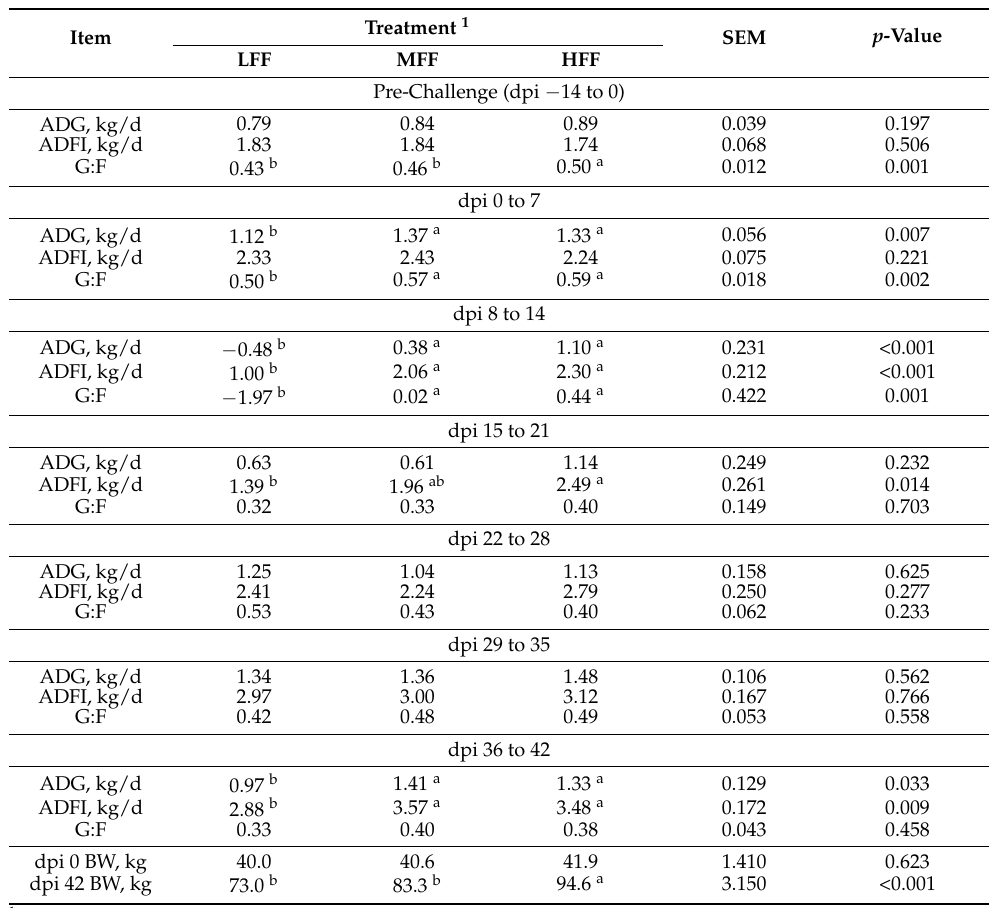
Table 3. Weekly growth performance of pigs inoculated with Brachyspira hyodysenteriae and fed a lowly fermentable diet (LFF), an intermediate fermentability diet (MFF), and a highly fermentable diet